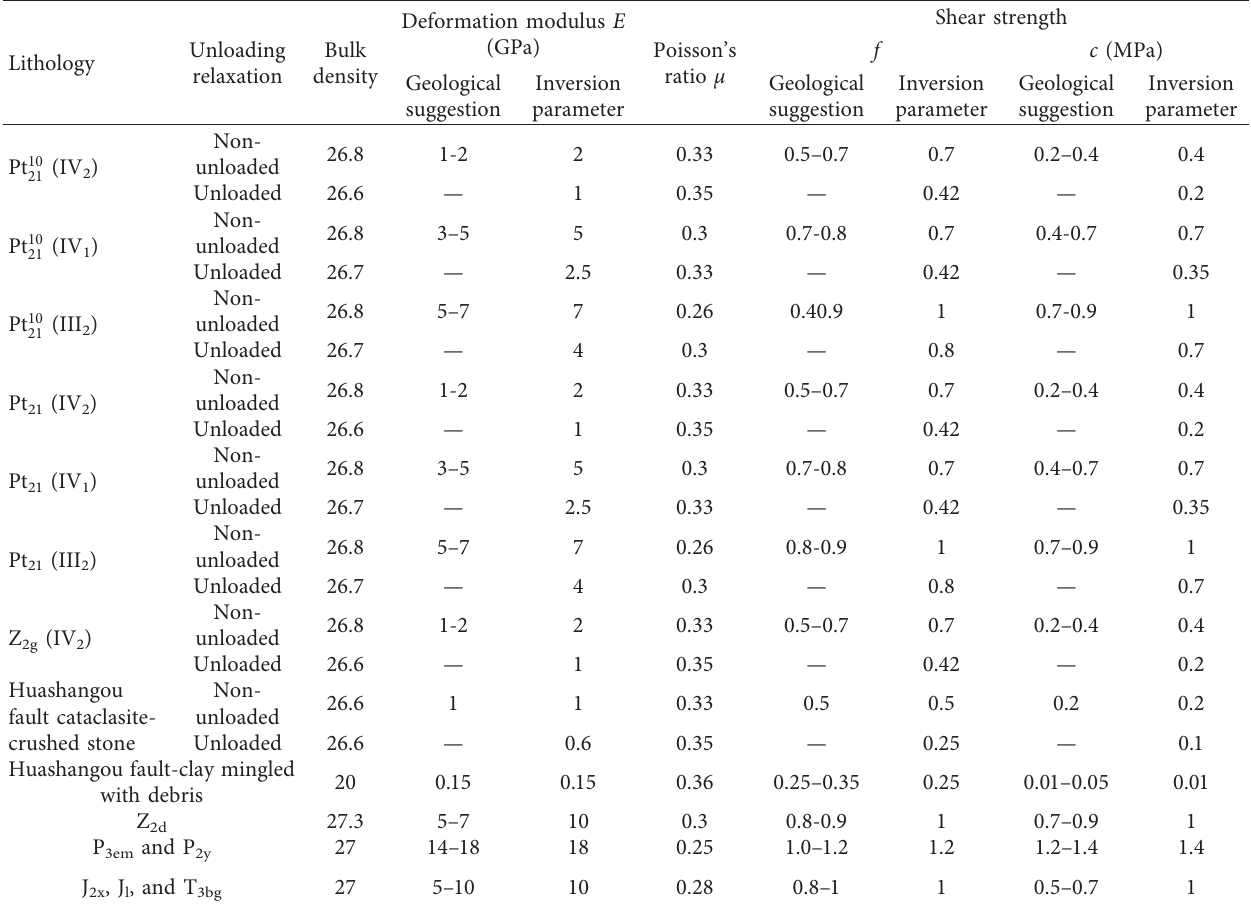
Table 1: Mechanical parameters of slope rock